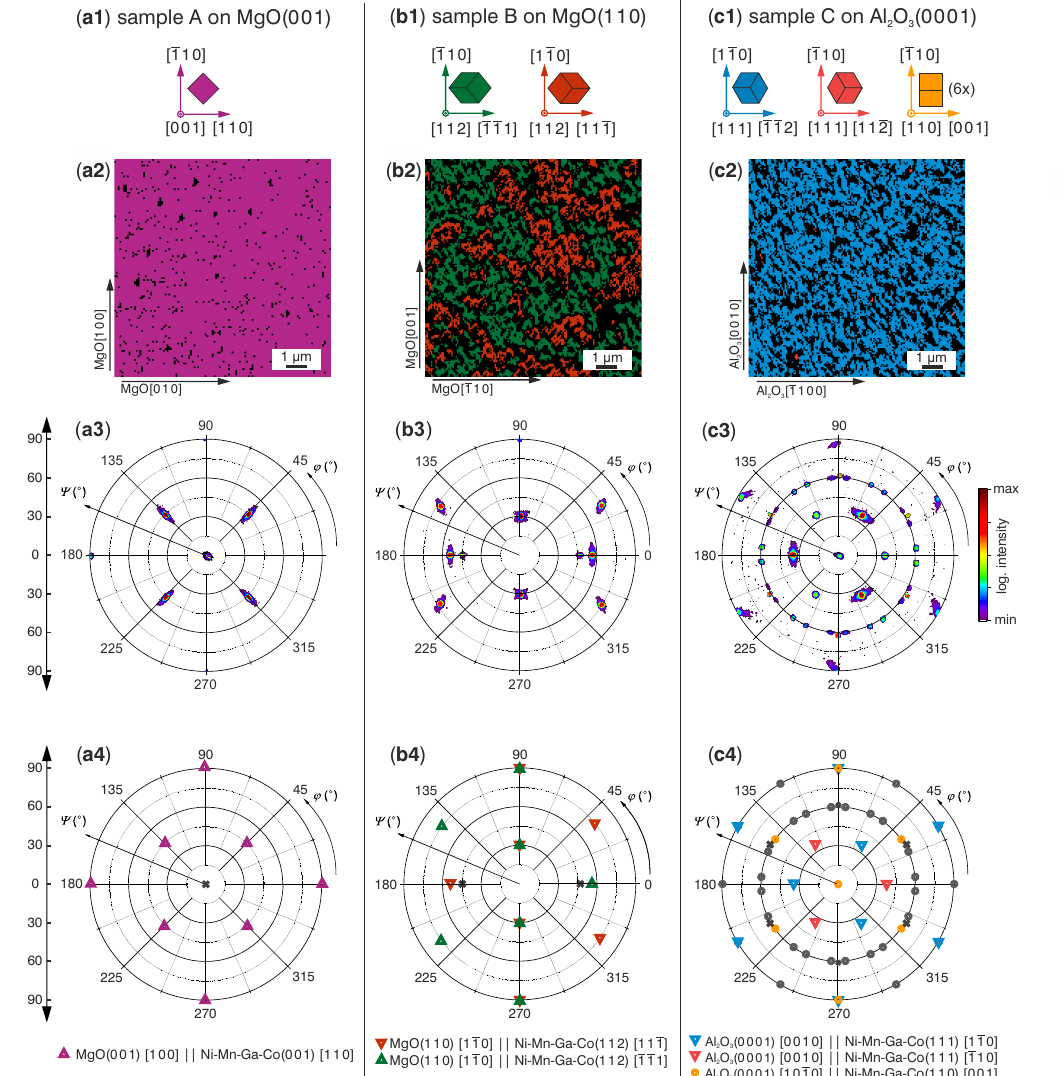
Figure 1. Main orientations and epitaxy relations of the investigated films: First column ( a1 – a4 ): Sample A on MgO(001), second column ( b1 – b4 ): Sample B on MgO(11 0) and third column ( c1 – c4 ): Sample C on Al 2 O 3 (0001). First row ( a1 – c1 ): Respective sketches of the cubic unit cell in the observed orientation. Second row ( a2 – c2 ): EBSD micrographs displaying the local orientation of representative areas of the films. The colour code refers to the orientations illustrated in ( a1 – c1 ). Black areas refer to points which could not be indexed during measurement. The substrate orientations marked at the edges of these figures are used for all figures in each column. Third row ( a3 – c3 ): {220}-texture measurements in logarithmic scale provide global information of the orientation and are compared with forth row ( a4 – c4 ): Calculated peak positions for the different orientations. The colours of the used symbols correspond to the orientations sketched in ( a1 – c1 ). Peak positions marked with a grey “ × ” come from the substrates. In ( c4 ), only one of the six (110)-orientations is highlighted in orange for better visibility, the others are sketched in grey and can be obtained by rotating this orientation around [110] in steps of 30 ◦